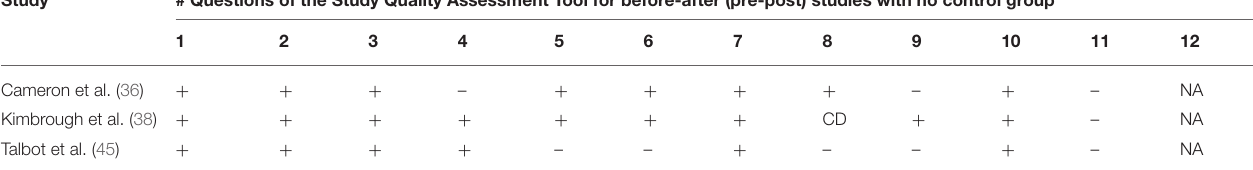
TABLE 4 | Critical appraisal for before-after studies with no control group.